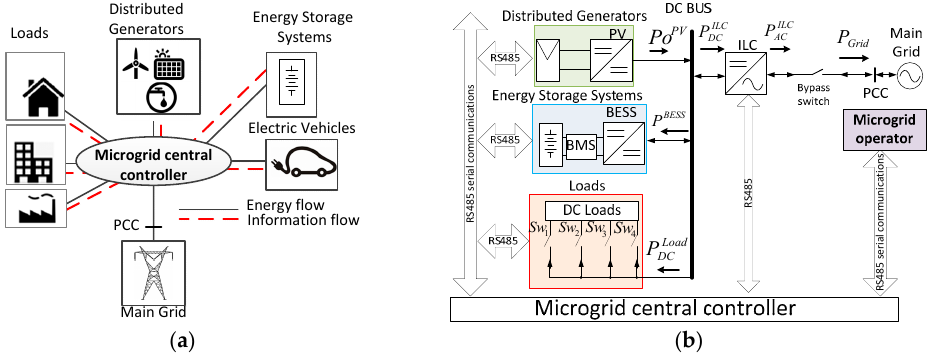
Figure 1. MG with central controller: ( a ) MG control system and intercommunication network; ( b ) DC Microgrid under study. Table 1. Main characteristics of the most widely used battery technologies in MGs.